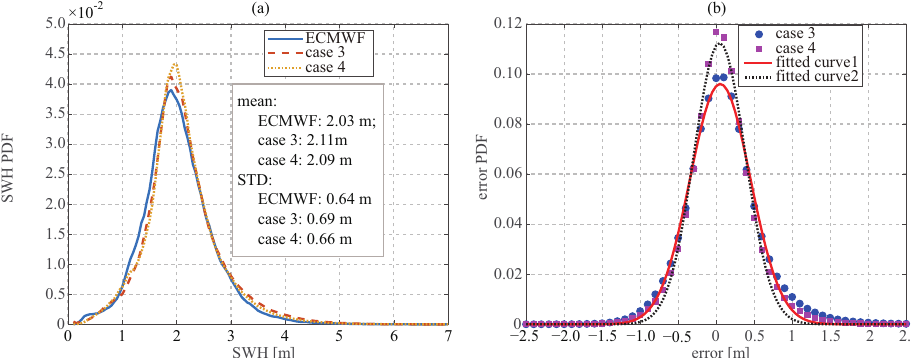
Figure 7. Probability density functions of ( a ) the retrieved SWH and ECMWF data and ( b ) error between the retrieved SWH and ECMWF